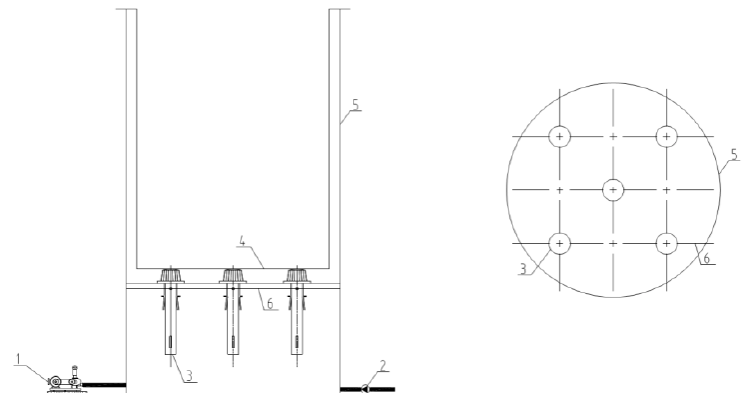
Figure 13. Catalyst life and Effectiveness evaluation reactor. (Left: front view; Right: top view).